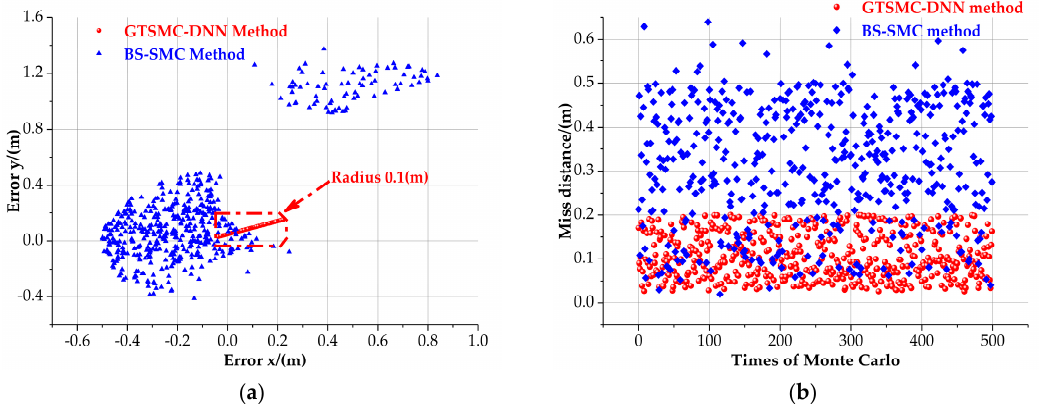
Figure 17. ( a ) The distribution of the 500 intercept points; ( b ) The characteristic of the relative dis-